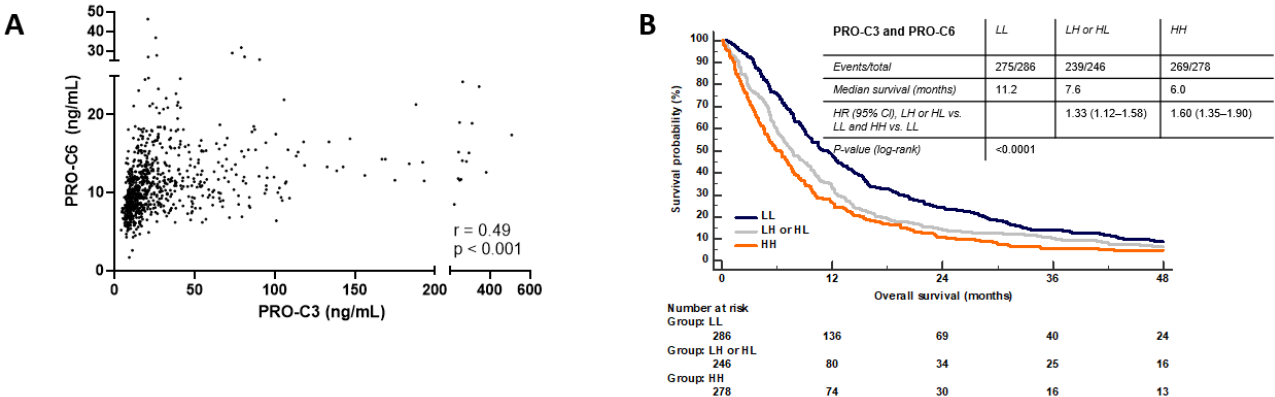
Figure 6. ( A ) Correlation between PRO-C3 and PRO-C6 biomarker levels were assessed using Spear- man’s correlation coefficient (r). ( B ) Kaplan-Meier plots showing the association between combination PRO-C3 and PRO-6 and overall survival in patients with pancreatic ductal adenocarcinoma (stages 1–4, n = 810). Patients were divided in three groups: (1) low PRO-C3 and low PRO-C6 (LL), (2) low PRO-C3 and high PRO-C6 or high PRO-C3 and low PRO-C6 (LH or HL), (3) high PRO-C3 and high PRO-C6 (HH). Blue line: low biomarker levels ( ≤ median). Orange line: High biomarker levels (>median). Hazard ratios (HR), 95% confidence interval (CI) and log-rank tests are shown. A p < 0.05 was considered significant.